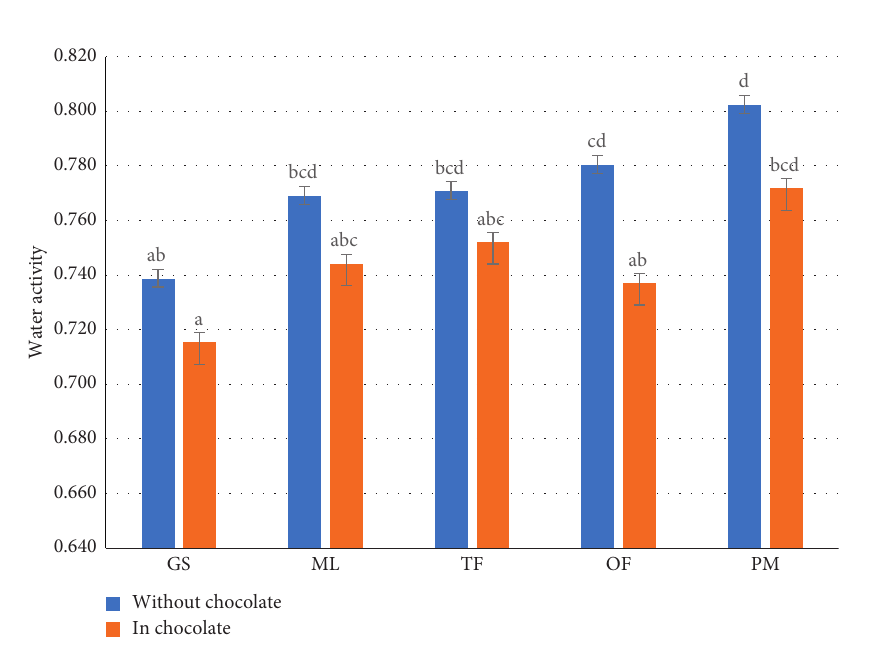
Figure 1: Impact of different syrup applications on water activity of high-protein bars without chocolate covering and with chocolate covering. Letters (a-d) indicate significant differences at P < 0.05 (Tukey’s HSD test). OF oligofructose, TF—tapioca liquid fiber, ML—maltitol, PM—chickpea-maize liquid fiber.